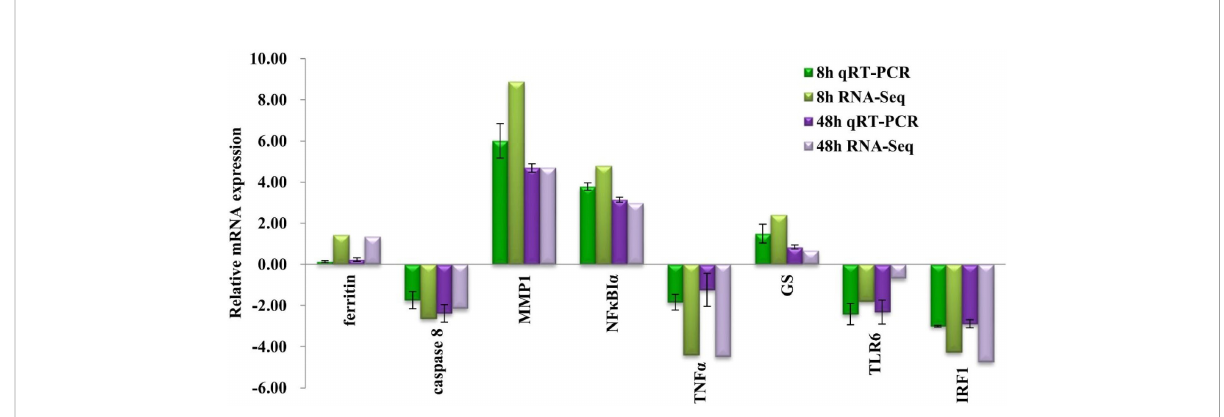
FIGURE 5 Expression patterns of selected differentially expressed genes (DEGs) at challenge time of 8 and 48 h compared with control group (A0h) with triplicates by qRT-PCR and RNA-seq analysis. The bars above the horizontal axis show that genes whose expression levels have increased after challenge, whereas those below the axis indicate the genes with decreased expression after Vibrio